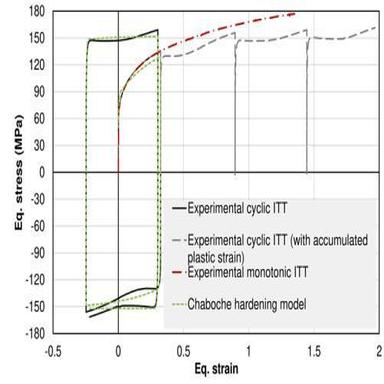
Experimental cyclic ITT with its calibrated Chaboche model flow curves in comparison with the monotonic ITT flow curve (color should be used in print).